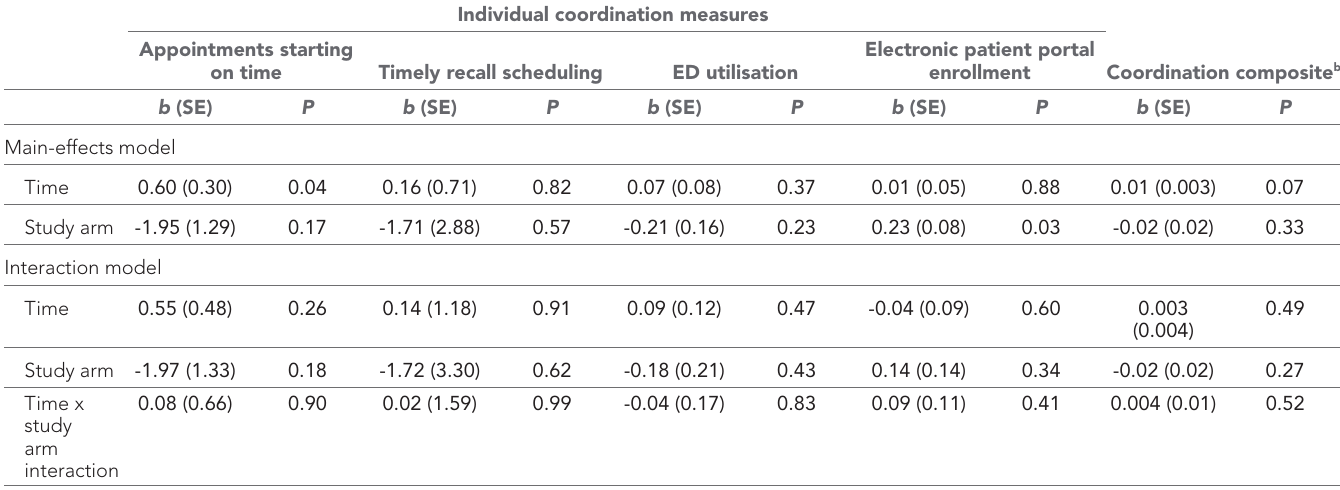
Individual coordination measures